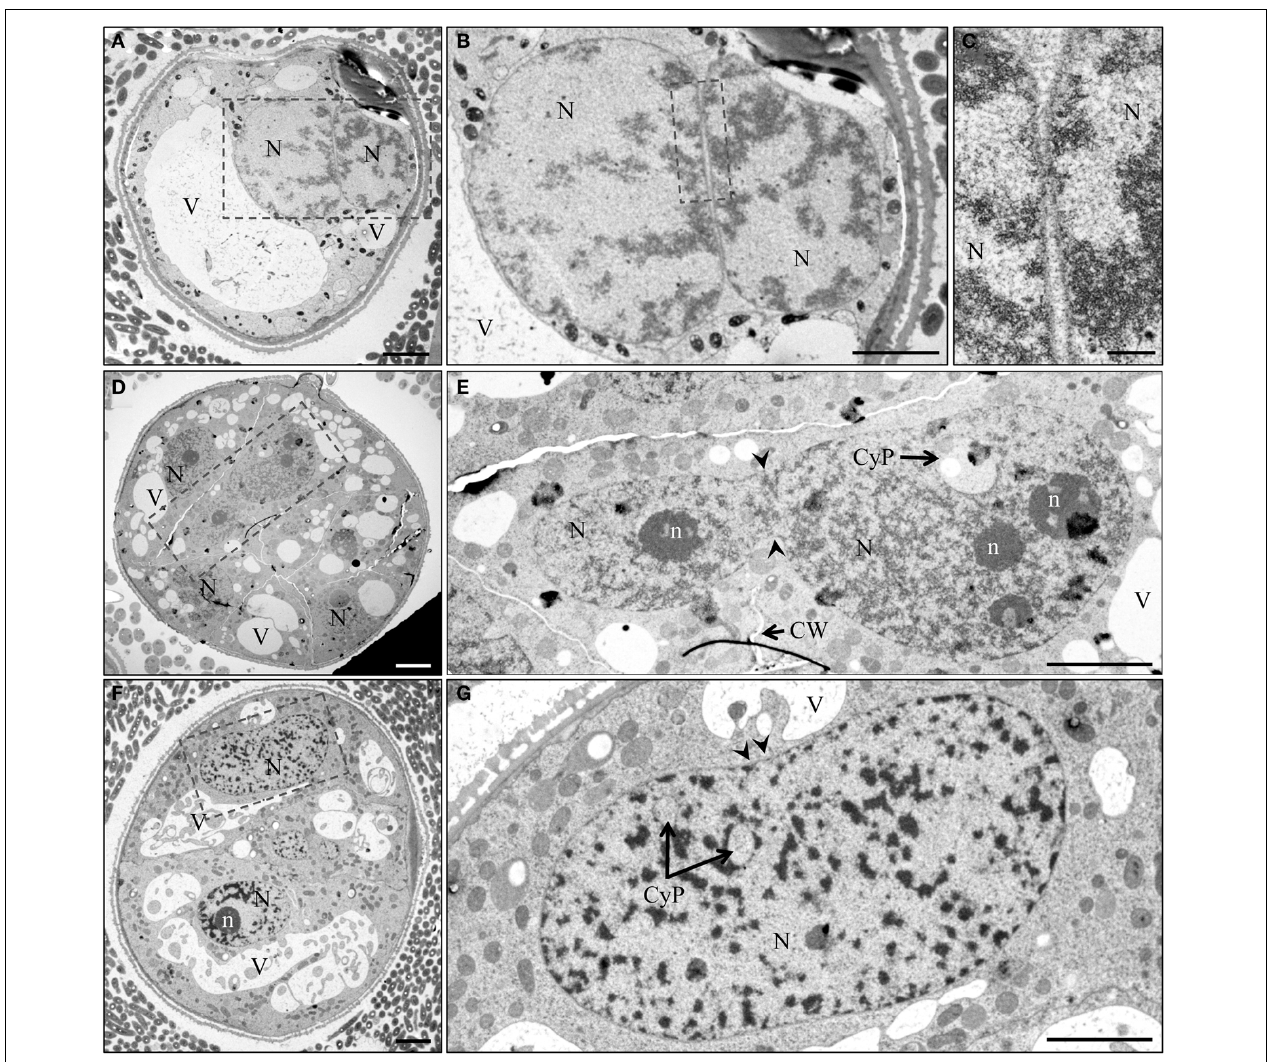
FIGURE 7 | TEM micrographs of nuclear fusion at different stages of pollen embryogenesis. (A) Induced immature pollen during first day of culture with two nuclei in close vicinity. (B,C) Detail of (A) shows the absence of cell wall and the close proximity of the nuclear envelopes. Arrow indicates region of assumed membrane fusion. (D) Multicellular structure 7 days after initiation of pollen embryogenesis. (E) Two nuclei